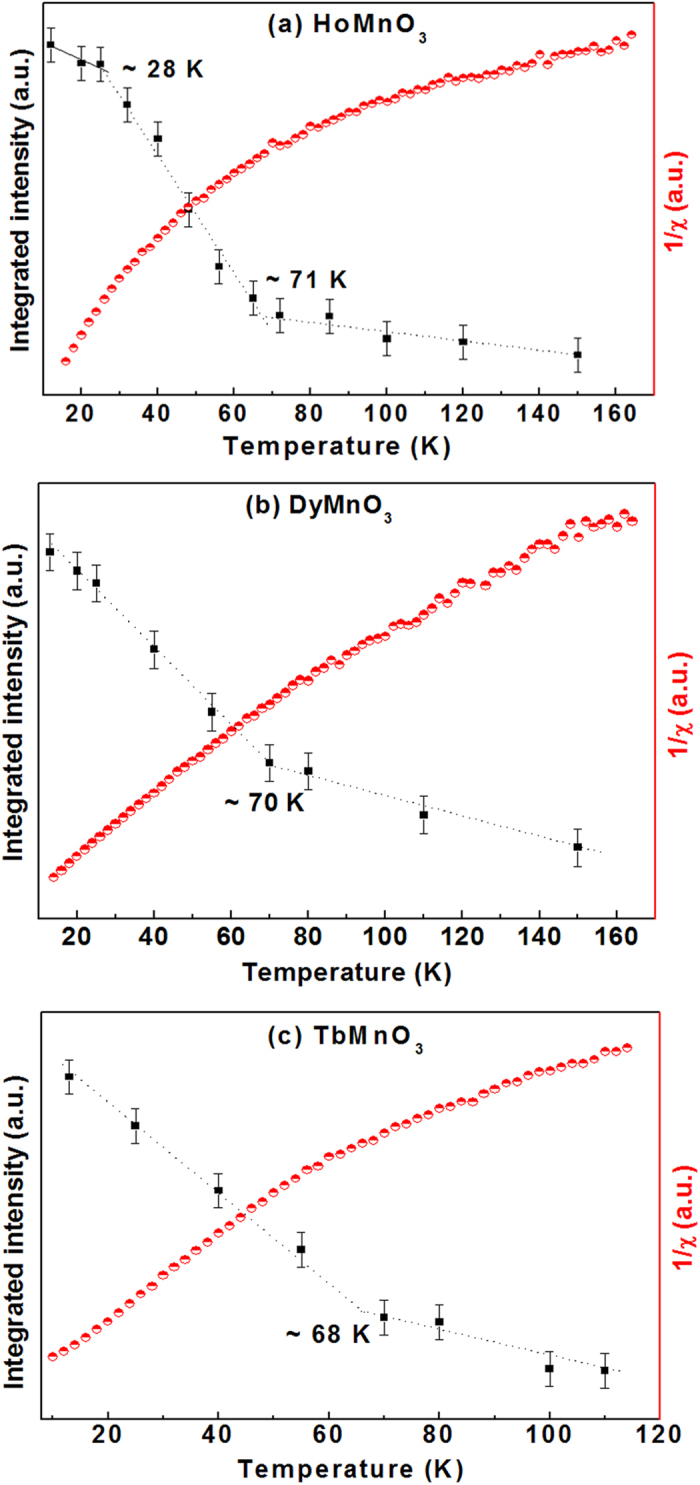
Temperature dependence of the integrated intensity of the difference Raman spectra in the range 700–1000 cm−1 (filled square) and of magnetization measurement (half-filled circle) of(a) HoMnO3, (b) DyMnO3, and (c) TbMnO3 thin films.